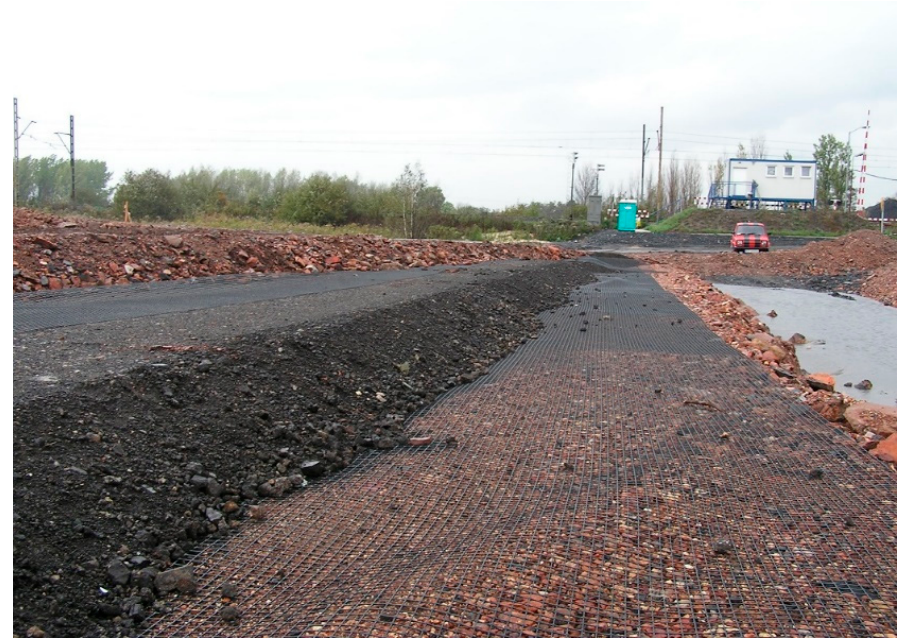
Figure 21. Example of geomattress formed from geogrids and recycled aggregate (mining wastes).